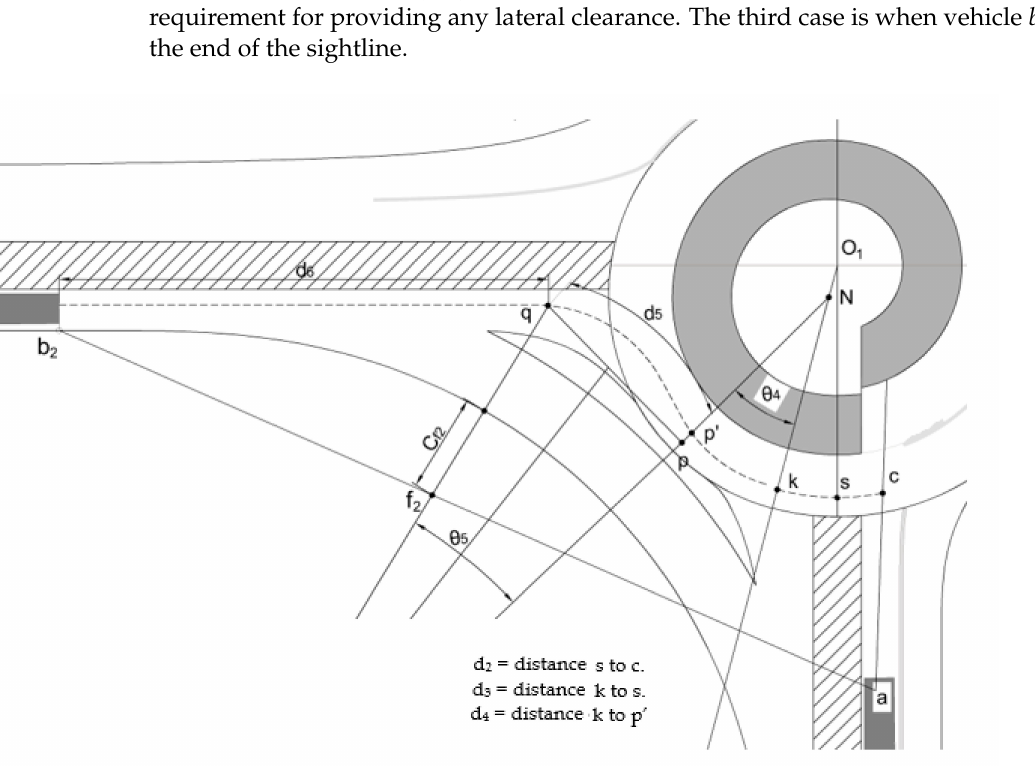
Figure 5. Geometry of ISD of the approaching and conflicting-entering